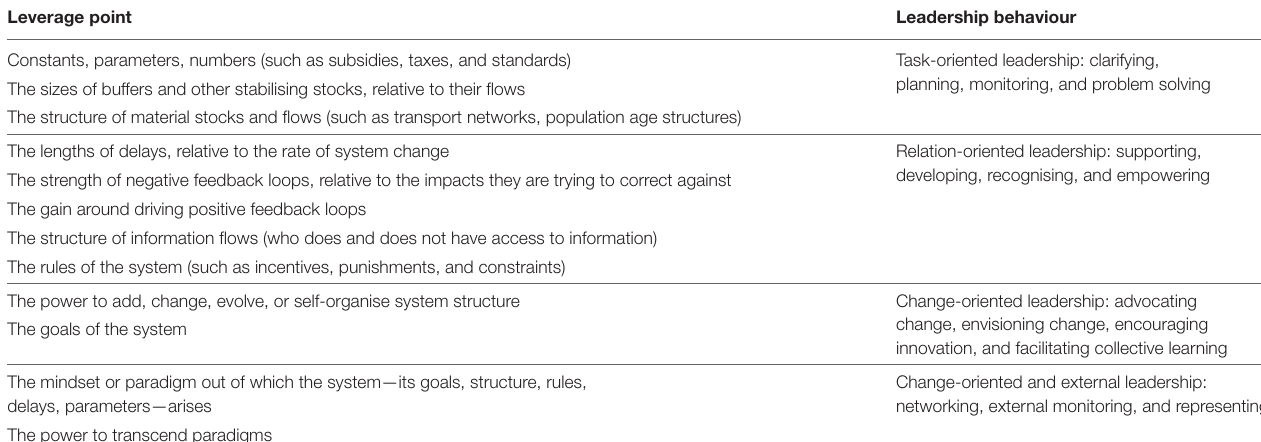
tAbLe 3 | Ranked list of leverage points at which to intervene in complex systems, from least to most effective, according to Meadows (53), in relation to leadership behaviour according to Yukl (62). Leverage point Leadership